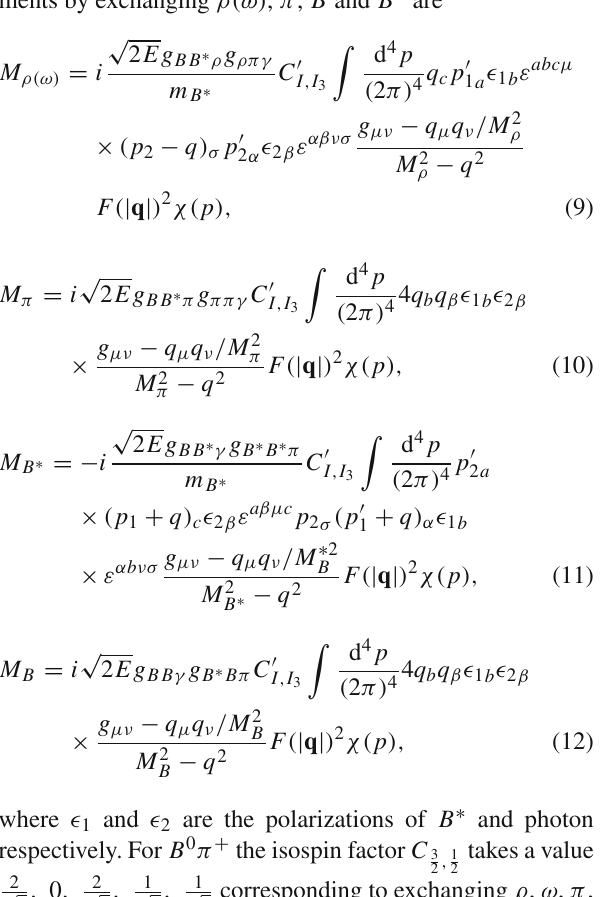
The Feynman diagrams for radiative decays of the B π molecule are shown in Fig. 2. Figure 2a corresponds to exchanging ρ , ω or π , while Fig. 2b is for exchanging B or B ∗ . Following Refs. [32,33,35] the transition matrix